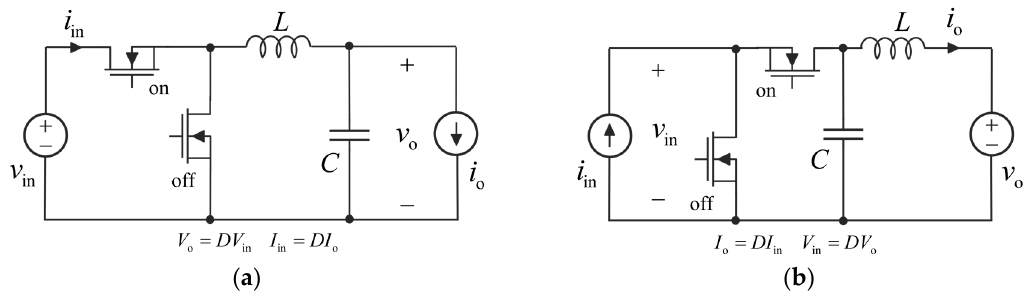
( b ) Figure 11. Application of duality transformation to ( a ) voltage-fed superbuck converter (solid line) to implement; and ( b ) the corresponding current-fed superbuck converter. The duality transformation will produce a converter, which has, in principle, the same steady-